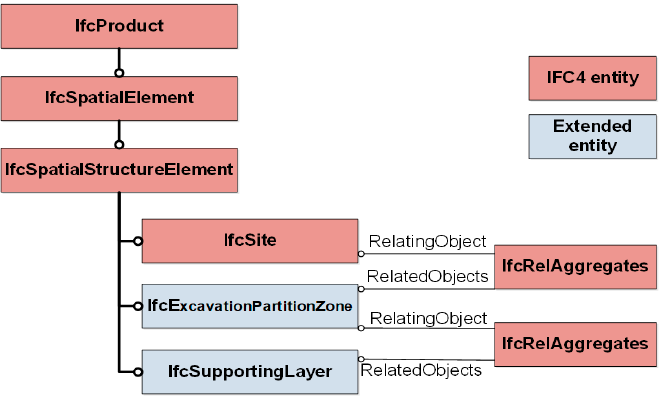
Figure 7. Spatial levels in deep excavation and relationships between spatial entity objects.